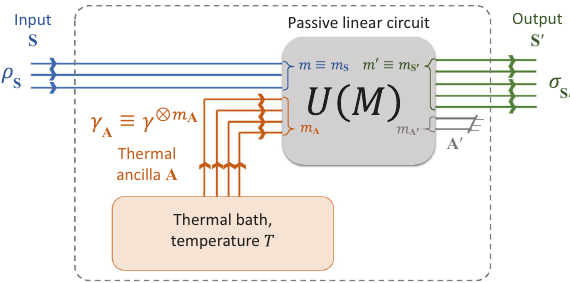
Fig. 1 Bosonic linear thermal operations (BLTO). The transfor mation effected by the contents of the dashed box de fi nes a generic BLTO from an m -mode input system S to an m 0 mode output system S 0 . The orthogonal symplectic transformation M on the phase space of SA induces the passive linear unitary U ( M ) on the corresponding Hilbert